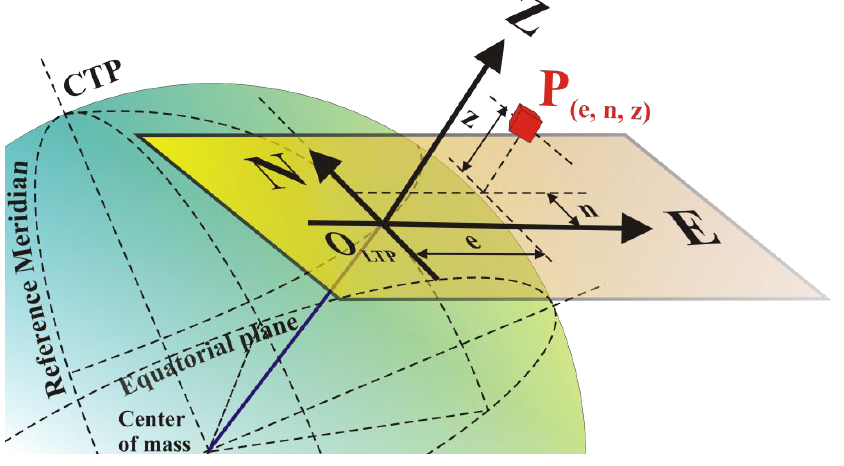
Figure 8. Local Tangent Plane system of coordinates for GPS agricultural